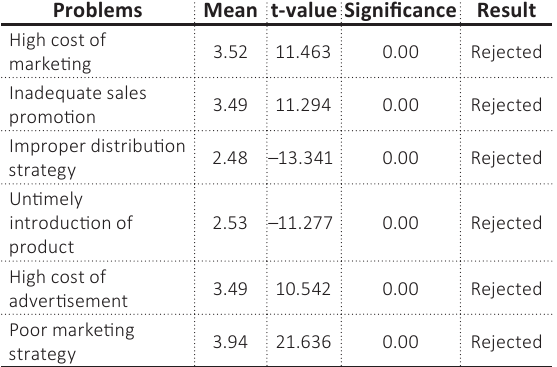
Source: Authors’ compilation.